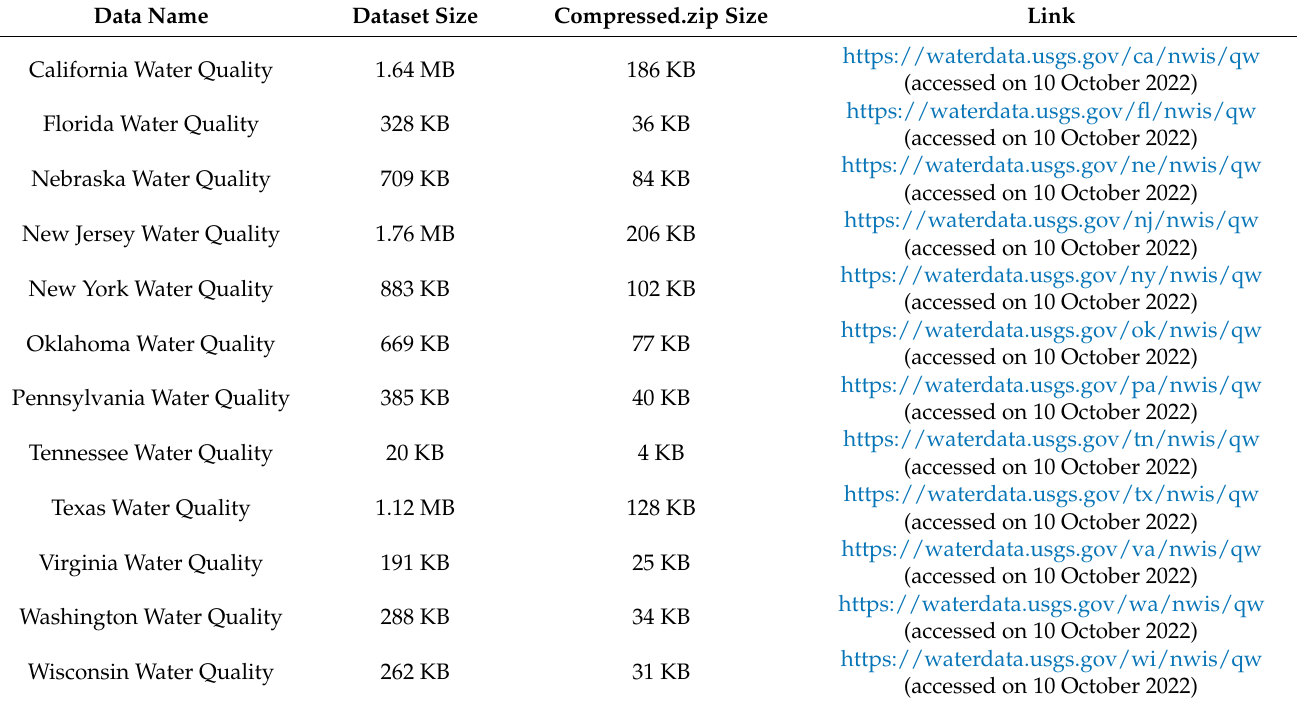
Figure 11. Comparing Tx-Cost for water quality data flow between blockchain-only and blockchain with DDS. Table 2. Datasets for